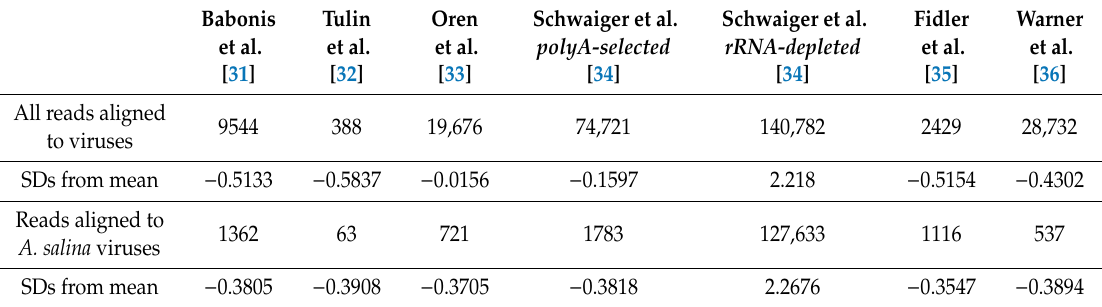
Figure 4. The number of reads mapped to Nematostella viral sequences assembled from all merged datasets presented as Reads Per Million (RPM) ( a ) and the fraction of total reads which mapped to A. salina viruses ( b ). Table 2. Summary of remapping results including the total number of reads mapped to assembled viral contigs from the merged dataset and number of reads mapped to putative Artemia salina viruses; SDs—number of standard deviations from mean calculated on the number of reads normalized to sequencing